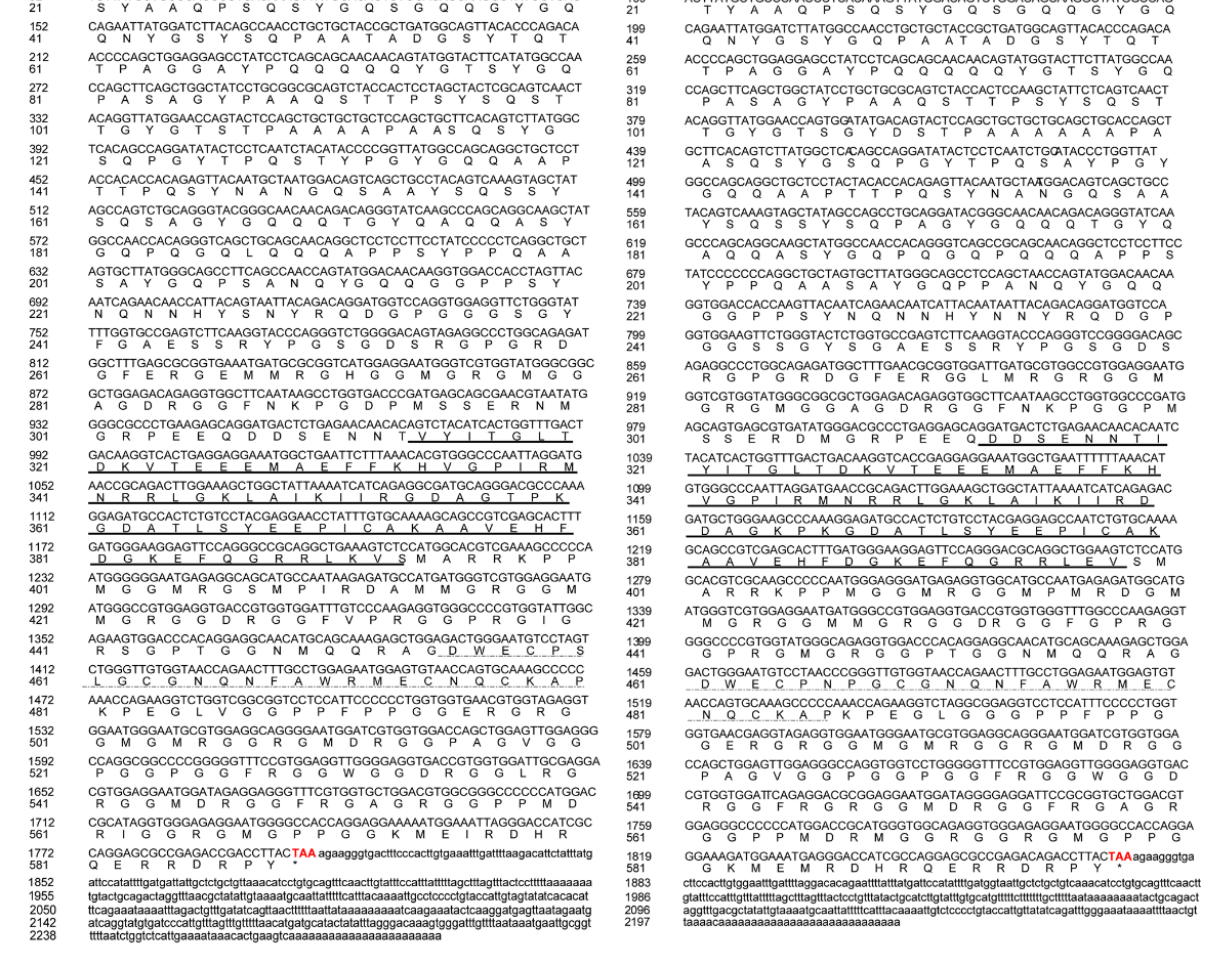
Figure 1. The ORF and predicted amino acid sequences of Cs-ewsr1-w gene ( A ) and Cs-ewsr1- z gene ( B ). The UTR region sequence is represented in lowercase letters. The ORF sequence is represented in uppercase letters. The start codon and stop codon are bold in red. An asterisk (*) represents the stop codon at the end of the ORF. The RNA recognition motif is represented by an underscore and the Ran binding protein zinc finger domain is represented by a dot-dash underline. The phylogenetic tree was constructed by using Ewsr1 proteins from 17 different species. The results showed that two Cs-Ewsr1 proteins were clustered together and then embedded with the teleost clade with Paralichthys olivaceus , Scophthalmus maximus and Poecilia formosa . The mammalian and the other species were clustered together (Figure 2). RNA recognition motif and Ran binding protein zinc finger domain were conserved in all the aligned species, including teleost, amphibians, and